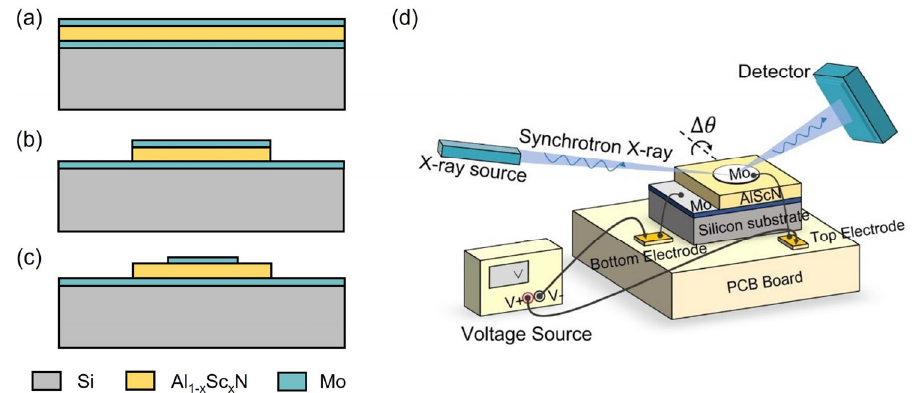
Figure 1. ( a ) Mo/Al 1 − x Sc x N/Mo piezoelectric stack deposition; ( b ) Top Mo/Al 1 − x Sc x N etching; ( c ) Top electrode Mo patterning; ( d ) Schematic of the measurement setup for the in situ synchrotron XRD characterization under static voltage supply.